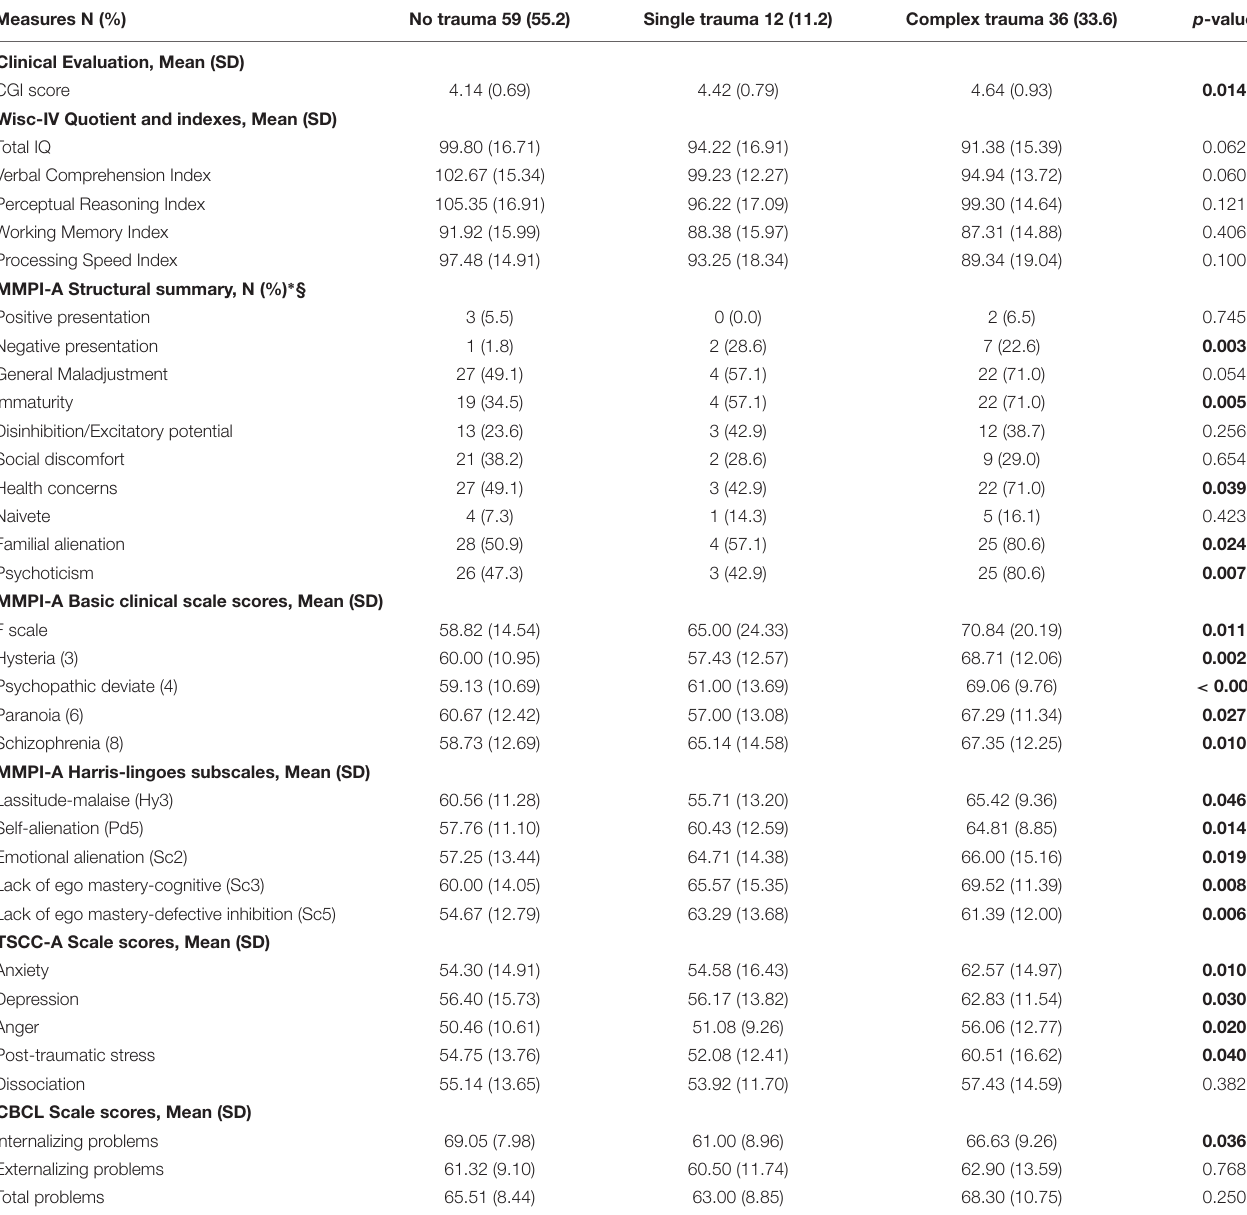
TABLE 2 | Psychometric measures of the three groups; differences were assessed by Chi-Square ( ∗ ) and One-Way ANOVA ( ◦ ). Measures N